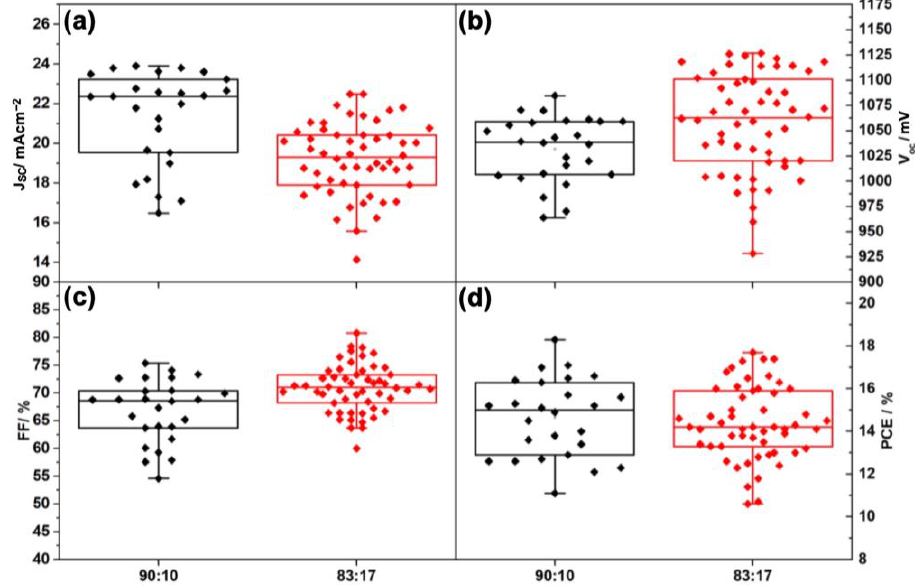
Figure 4. Statistics of PV parameters: J SC ( a ), V OC ( b ), FF ( c ), and PCE ( d ) of gold-based solar cells with different ratios of I: Br of 90:10 and 83:17.